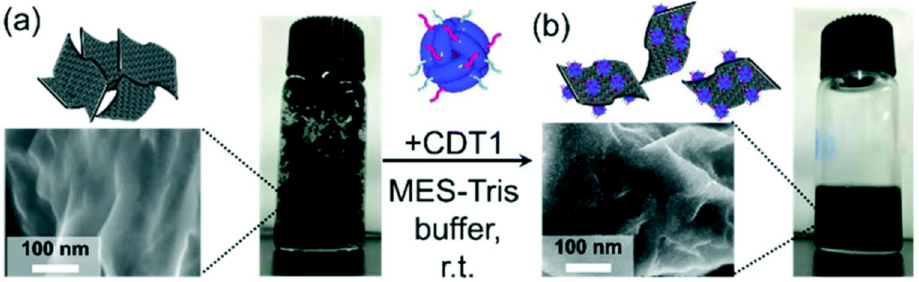
Figure 16. FE-SEM images and photographs of ( a ) graphene and ( b ) CDT1 with the iron oxide core adsorbed on the graphene. These materials were dispersed in water. Reproduced from [110] with the permission of the Royal Society of Chemistry.